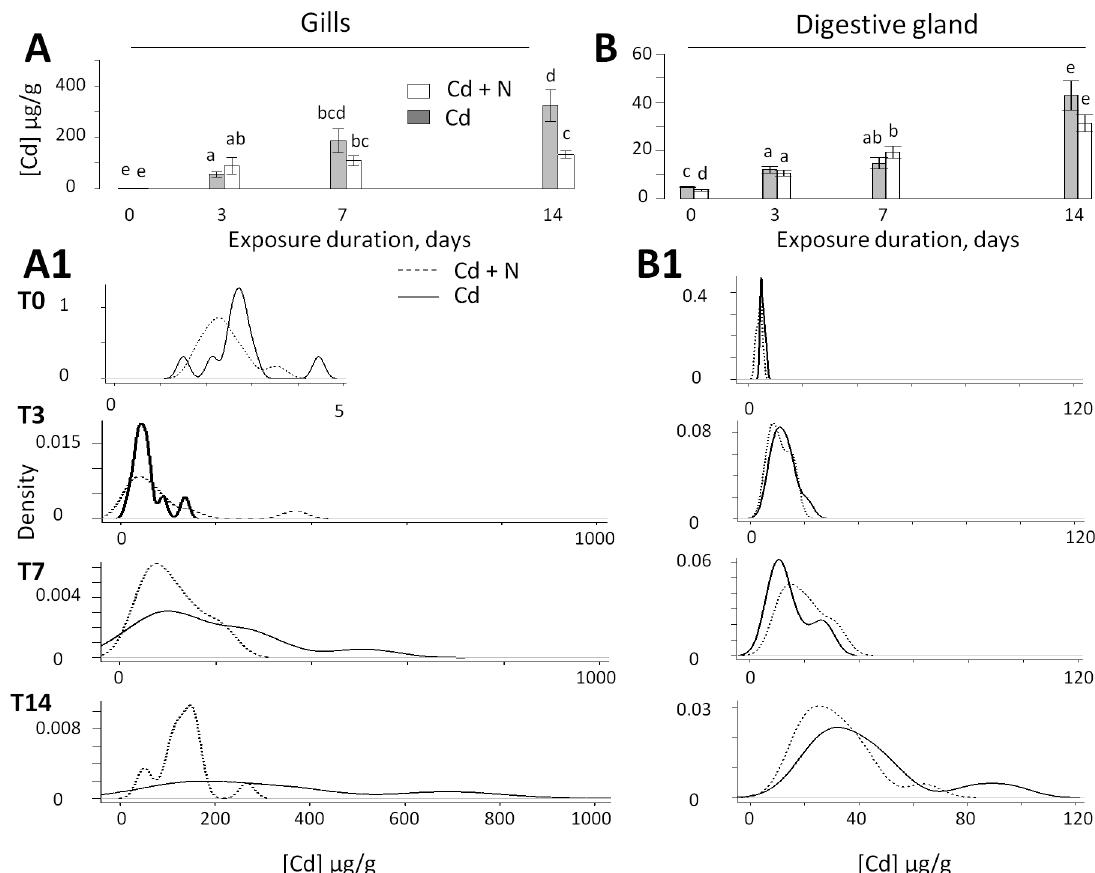
Fig 2. The change of cadmium concentration in the gills (A, A1) and digestive glands (B, B1) in oysters M . gigas . A: mean values ± 1 SE as a function of time in the gills; B, in the digestive glands. A1 and B1, Distribution of probability densities at day 0 (T0), day 3 (T3), day 7 (T7) and day 14 (T14). In the presence of cargo ship noise, the distributions were skewed to the lower values at T 3 , T 7 , and T 14 in the gills and T 14 in the digestive